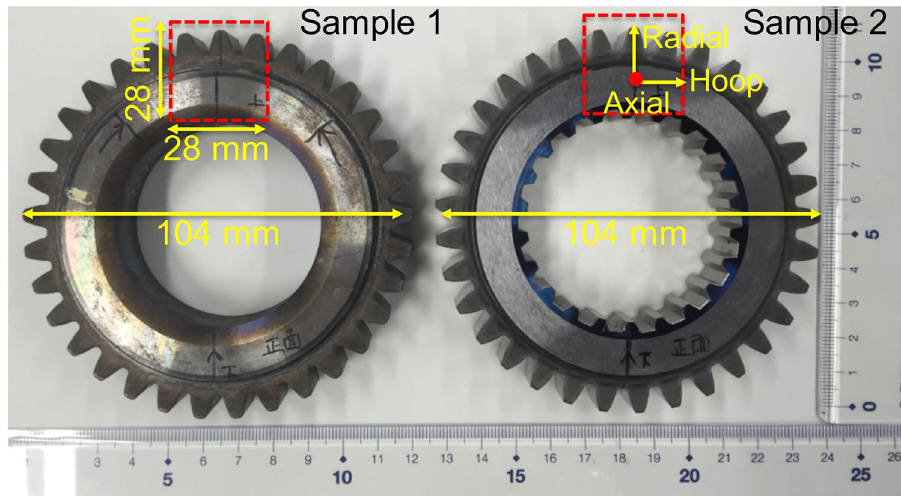
Figure 2. Photographs of the gears investigated in this work. The dashed boxes indicate the field of views of each sample examined by Bragg-edge imaging.